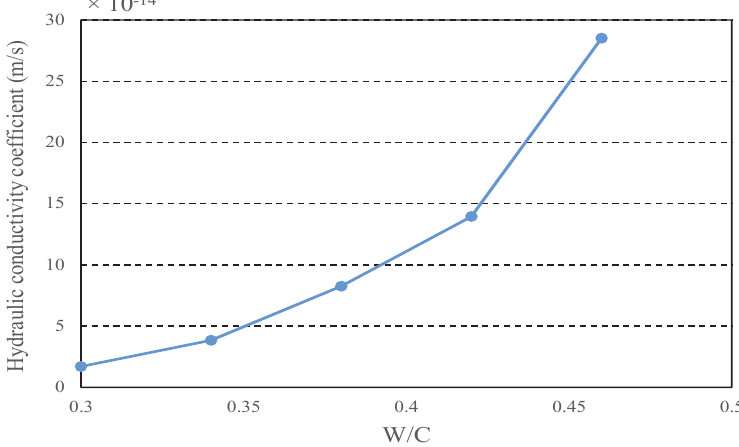
Figure 6: Hydraulic conductivity coefficient of concrete in terms of water-cement ratio